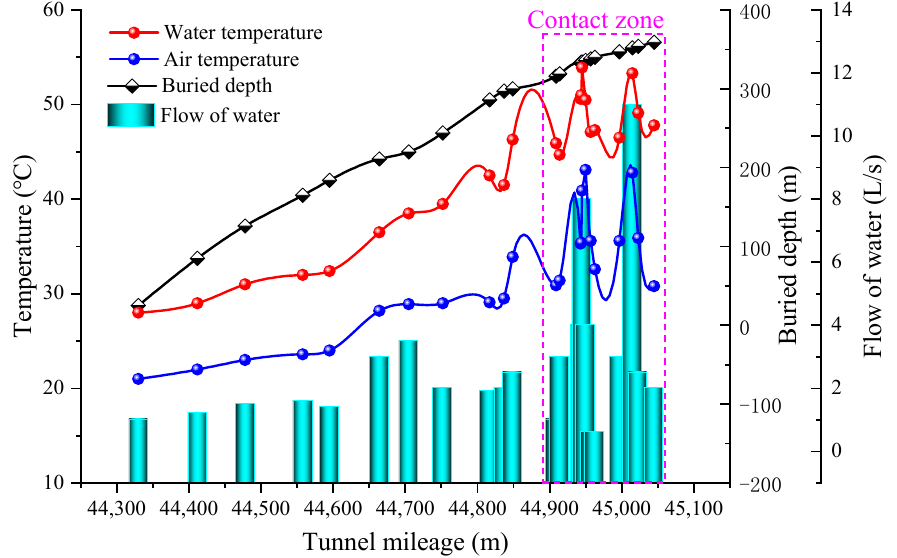
Figure 4. Variation curves of the water temperature, air temperature, buried depth, and flow of the water with tunnel mileage.